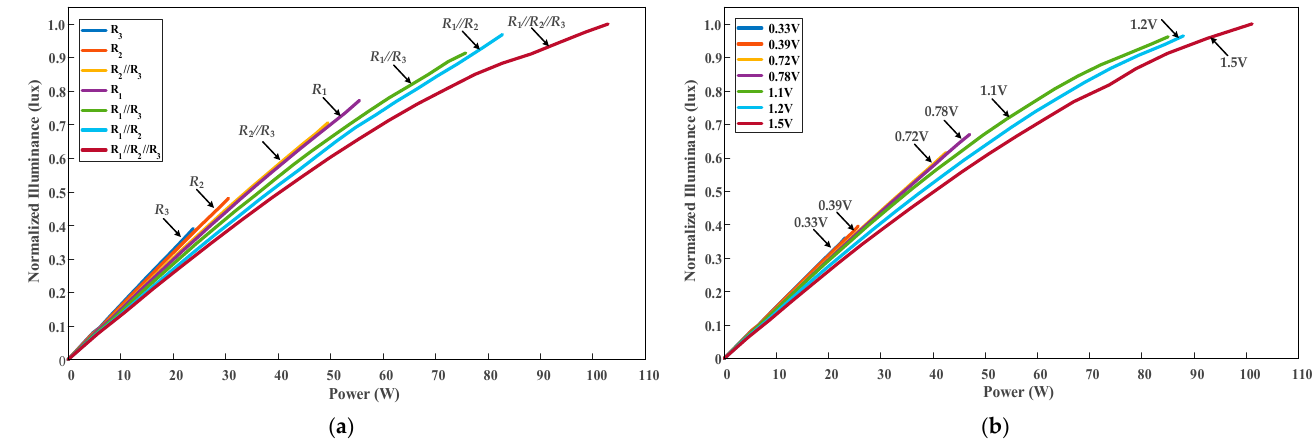
Figure 12. Measured I-P curves dimmed with: ( a ) VCSR method; ( b ) VDSV method. The quantitative computation and analysis are given to further confirm that the I-P curves measured by the studied dimming methods indeed improve the LED luminous efficiency. Comparing the proposed methods with the conventional PWM dimming, Figure 13 illustrates a conceptual diagram used to describe the estimation manner for improvement quantities of the luminous efficiency and power consumption obtained by the two dimming methods studied in this paper. When the power reaches the upper limit of the present dimming level, it will be switched to the next one. The control range of the next dimming level is from the upper bound of the previous level (i.e., the lower bound of the present level) to the upper bound of the present level, and so on. From Figure 13, under the same illuminance, the power difference between point A and point B, divided by the power value of point B, is defined as the percentage reduction of the driver power. On the other hand, as the driver output power is the same, the illuminance difference between point C and point D divided by the illuminance value of point D signifies the percentage increase of illuminance. Based on the ameliorative calculation mode as defined above, Tables 2 and 3 respectively list the quantified improvement effect of each dimming level done by the two methods, put forward as comparing with the counterpart, and Table 4 shows the entire average amelioration obtained for the full control range. From the test results, we can observe that the proposed methods have better luminous efficiencies and energy-saving effects than the conventional ones, especially as the LED is dimmed at low luminosity. This is consistent with the theoretical derivation and is closer to the actual luminous characteristics of the LED. These measured data also demonstrate the feasibility and effectiveness of the proposed methods and the remarkable advances in drive performance improvement as compared with their counterparts. Figure 14 shows the luminous efficiency (LE) curves and the corresponding LED currents of the proposed two methods and conventional PWM dimming. The entire dimming control range is divided into nine segments with a step of 10% dimming duty cycle, and the current flowing through the LED, as well as the corresponding LE obtained by three methods at each segment, are measured under the condition of feeding the identical power to light the LED. It can be seen clearly from Figure 14 that, in the low LED dimming ranges (below 80% duty cycle), the LEs of the proposed methods are better than those of the PWM dimming. From the relationship between the LED current and the LE shown in Figure 14, it can be further observed that the VDSV method has the best LE improvement performance and energy saving effect between the three methods. This is because at each dimming duty cycle, the VDSV dimming has the greatest LE boost, while the need for a driving current is least. Based on the measured data, when compared with the PWM dimming, the total average LE improvement of the devised VDSV and VCSR methods increased by 21.36% and 16.37%,